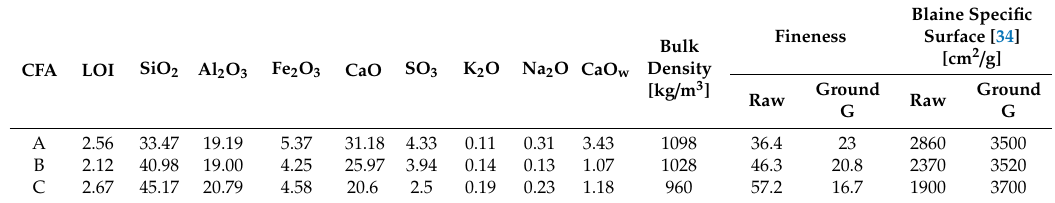
Table 3. Chemical composition of